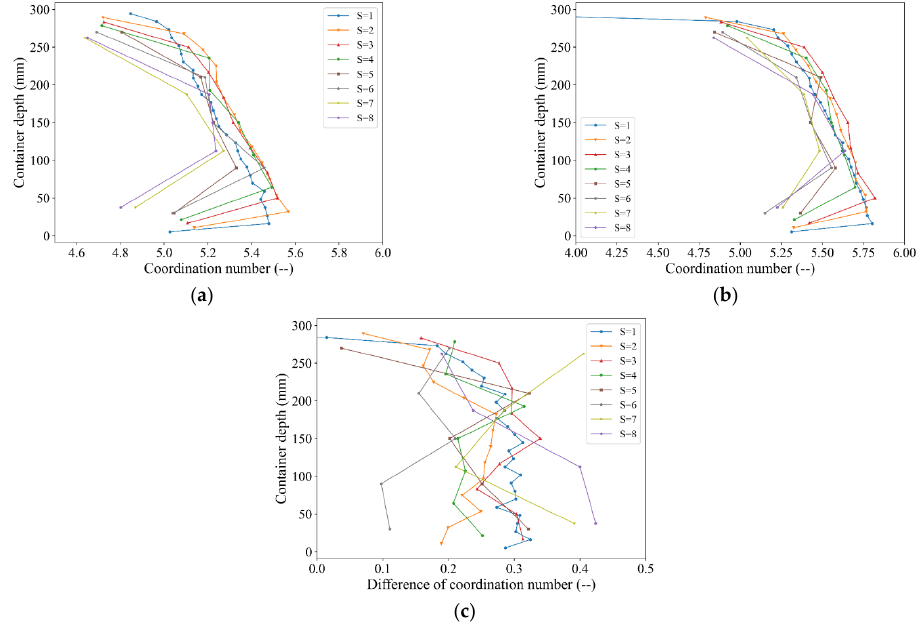
Figure 4. Coordination number distribution. ( a ) Before vibration; ( b ) After vibration; ( c ) Difference of coordination number after and before vibration.